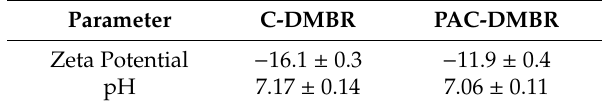
Table 3. The mean values of zeta and pH in the